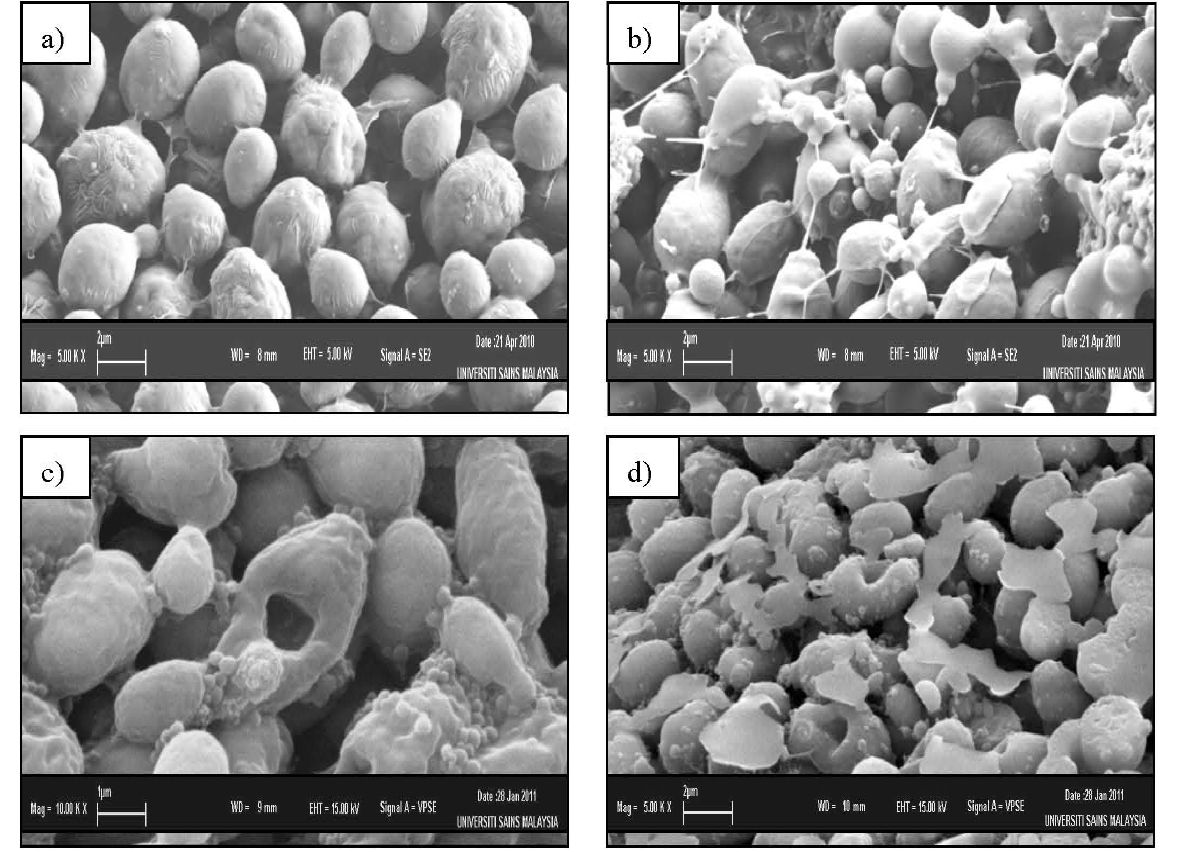
Figure 2. Scanning electron microscope photomicrograph of the untreated ( a ) and extract-treated ( b,c,d ) cells of Candida albicans